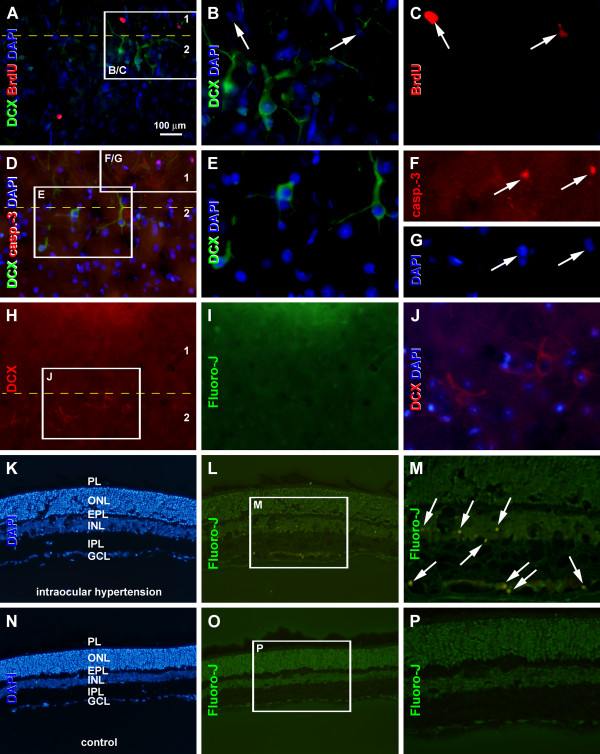
Representative data showing that doublecortin-immunoreactive (DCX+) cells around neocortical layer II in Pb-treated animals surviving 6 months do not colocalize with BrdU (A-C), active caspase-3 (D-G) or Fluoro-Jade C labeling (H-J). Markers and fluorescent channels are indicated on the left of each panel. Note that BrdU labeled cells (arrows) are present in layer I and upper III (A, C). Nuclei labeled for active caspase-3 are occasionally seen in layer I (D, F, and G). Fluoro-Jade C labeled cells are rarely detected in the cortex (H-J) or normal rat retina (N-P). In contrast, they are found in the rat retina 24 h after intraocular hypotension (K-M). PL: photoreceptor layer; ONL: outer nuclear layer; EPL: external plexiform layer; INL: inner nuclear layer; IPL: inner plexiform layer; GCL: ganglion cell layer. Scale bar = 100 μm in A applying to D, H, I, K, L, N and O; equal to 50 μm for B, C, E-G, J, M and P.